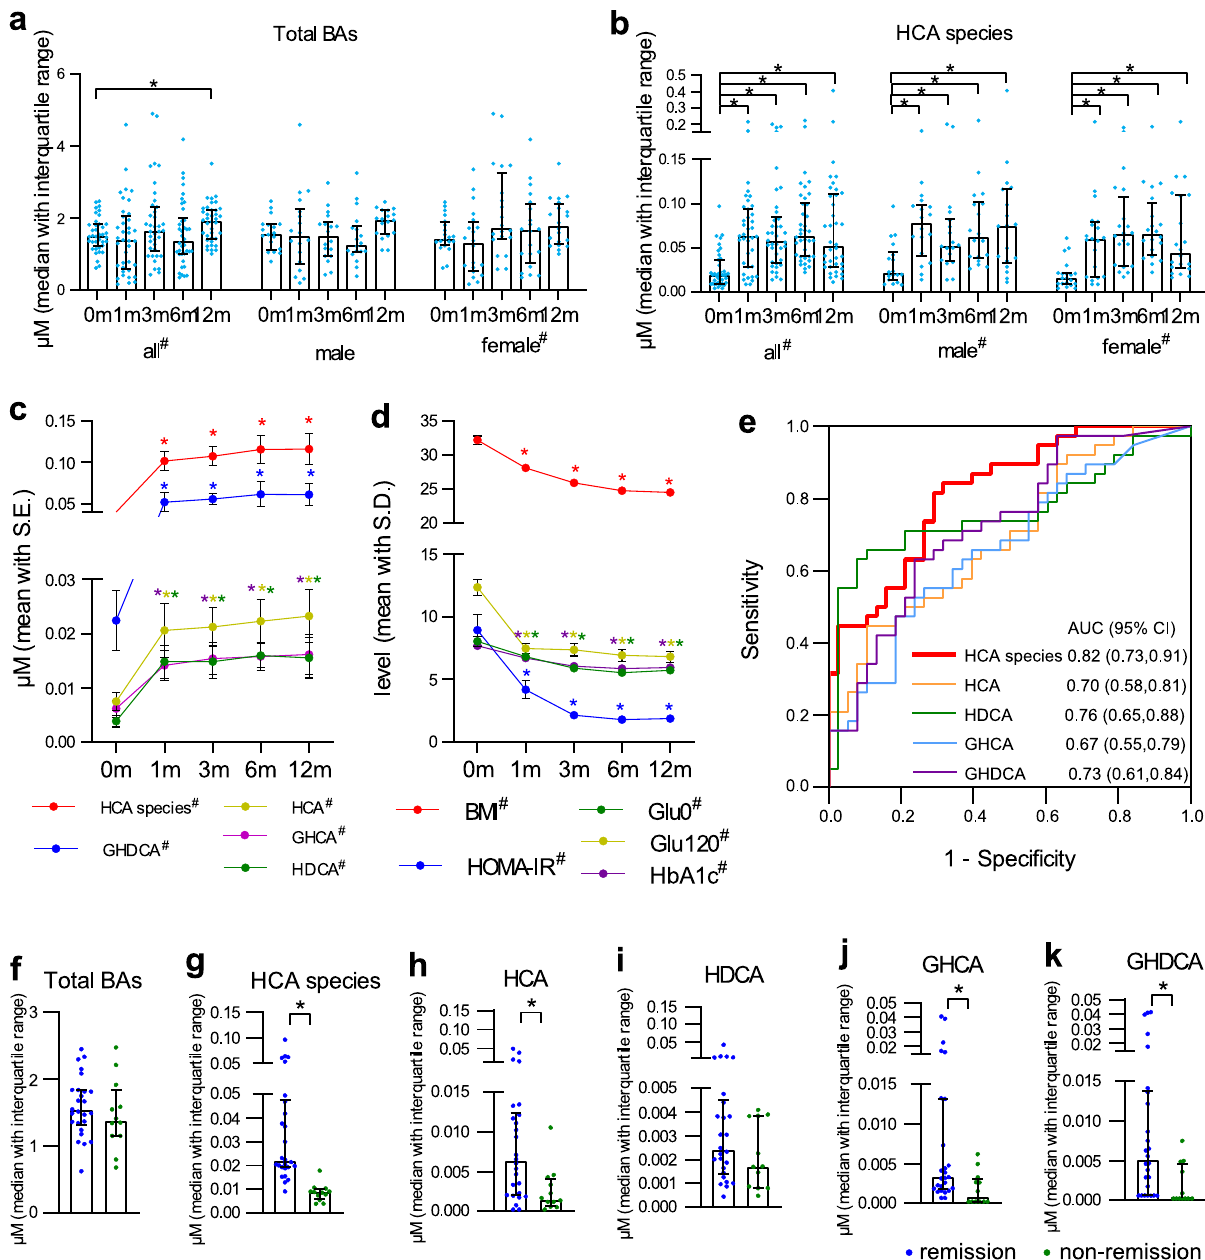
Fig. 3 Performances of surgery-induced changes of HCA species in the gastric bypass surgery intervention study. a , b Total BAs and total HCA species serum concentrations before and after gastric bypass surgery in all ( n = 38), male ( n = 18) and female ( n = 20) patients with obesity and diabetes. c Serum concentrations of total and individual HCA species before and after surgery. d BMI and glycemic markers before and after surgery. e ROC analysis of the changes (12 months vs. baseline) of total and individual HCA species. f – k The serum concentrations of total BAs, total HCA species, and individual HCA species at baseline (0 month) in the remission group ( n = 26) and the non-remission group ( n = 12). Data are expressed as median with interquartile range ( a , b , f – k ), mean with SE ( c ) and mean with SD ( d ). * indicates statistical signi fi cance ( p < 0.05) based on ( a – d ) two-sided Wilcoxon signed-rank test when compared with baseline (0 month), and ( f – k ) two-sided Mann – Whitney U test when comparing remission and non-remission